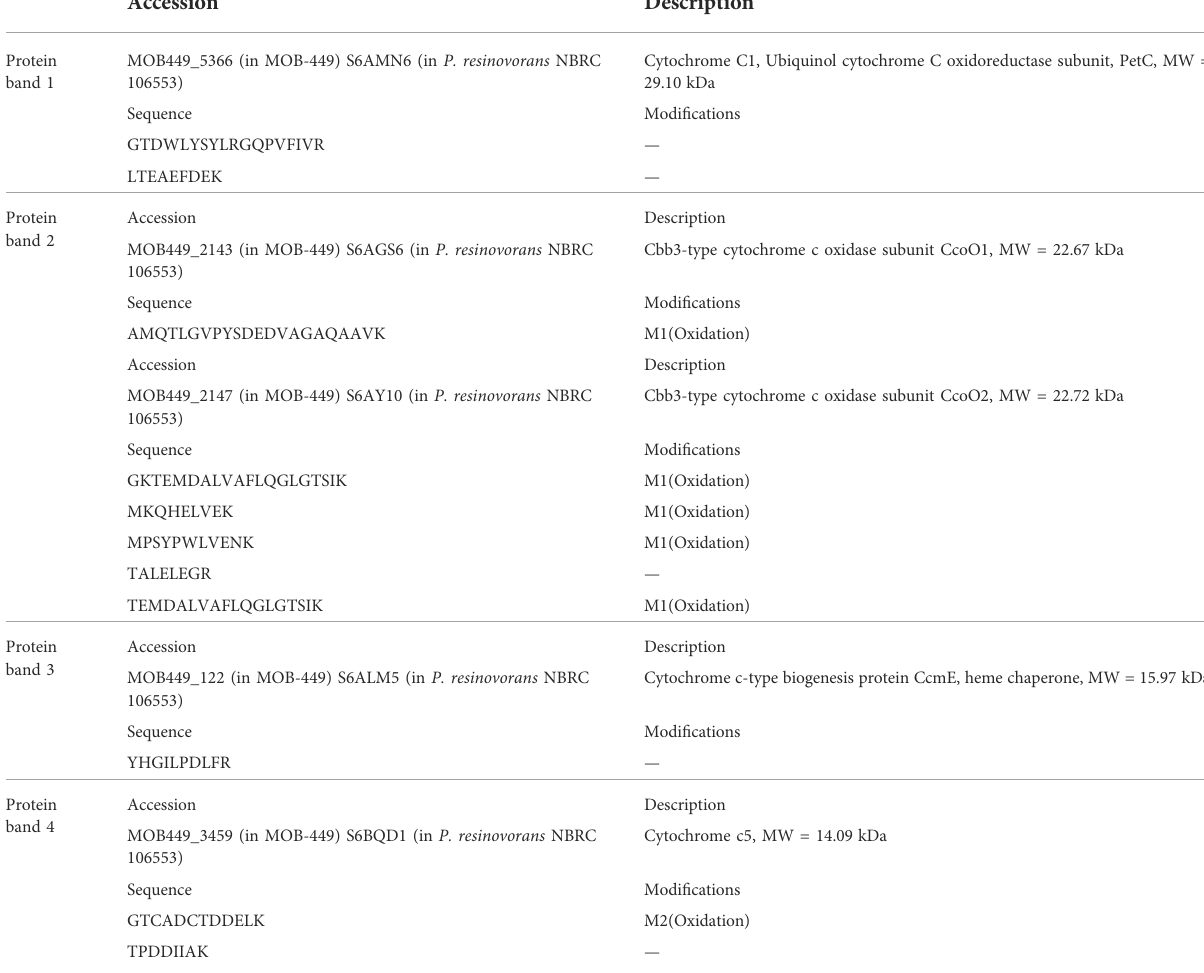
TABLE 2 Nano LC-MS/MS analysis of the bands extracted from TMBZ gels of 3-day-old MOB-449 bio fi lms grown at 18 ° C or 30 ° C in Lept or Lept + Mn